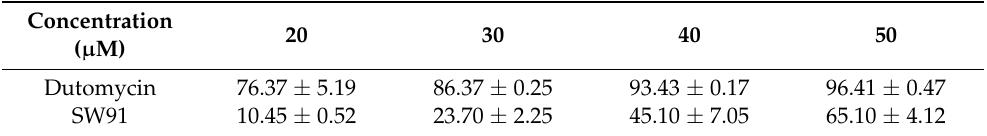
Figure 5. Cell cycle percentage stacking plots for different time periods 0-24 (h) to illustrate the cycles of cells treated with drugs at their IC 50 concentrations: ( a ) plot of cell cycle percentage stacking at different time periods 0–24 (h) after addition of dutomycin; ( b ) plot of cell cycle percentage stack- ing at different time periods 0–24 (h) after addition of SW91; ( c ) plot of cell cycle percentage stacking at different time periods 0–24 (h) after addition of control. 2.5. UV–Vis Absorption Spectroscopy UV–Vis spectrophotometry is one of the most reliable methods of detecting the inter- action between compounds and DNA. The UV analysis of the solution of dutomycin and SW91 and CT-DNA in vitro showed a correlation. With the gradual addition of CT-DNA, the electronic clouds of dutomycin and SW91 interacted strongly with the ones of the DNA bases, triggering a hypochromic effect with no significant shift in peak position. This change in absorbance was mainly due to the noncovalent interactions: external contact